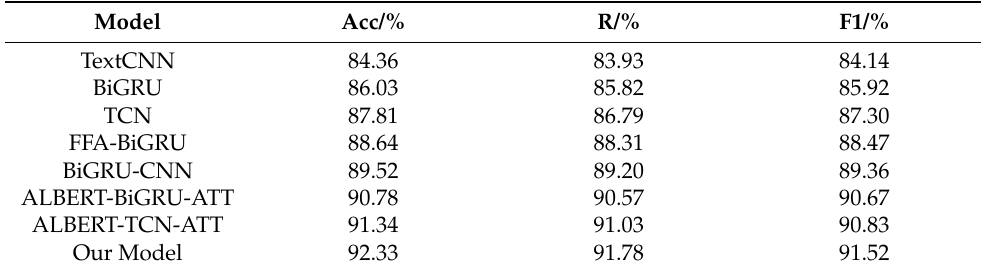
Table 3. Comparison results of the different models.